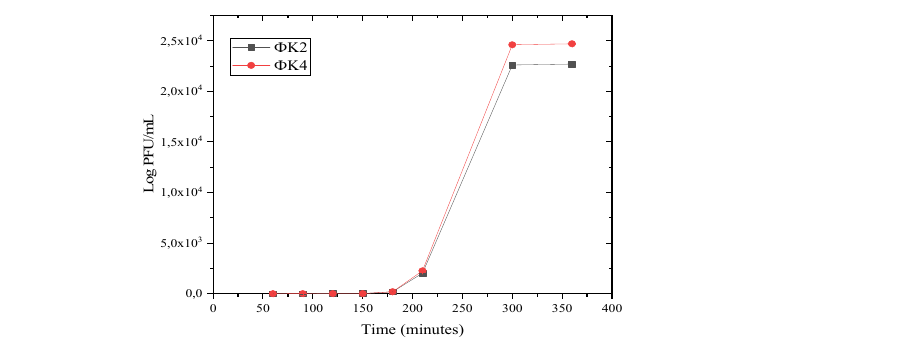
Figure 4. One-step growth curve of Φ K2 and Φ K4. Results are presented as mean values ± SD from three independent experiments.